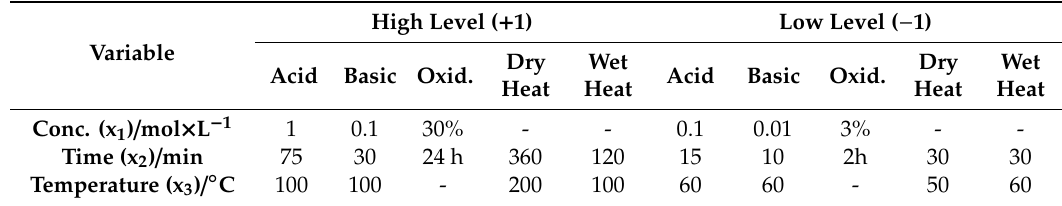
Table 6. Real values of the variables used in the design of